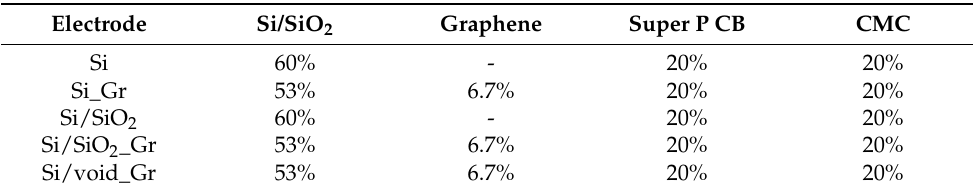
Table 1. Electrode Composition (% w / w ).